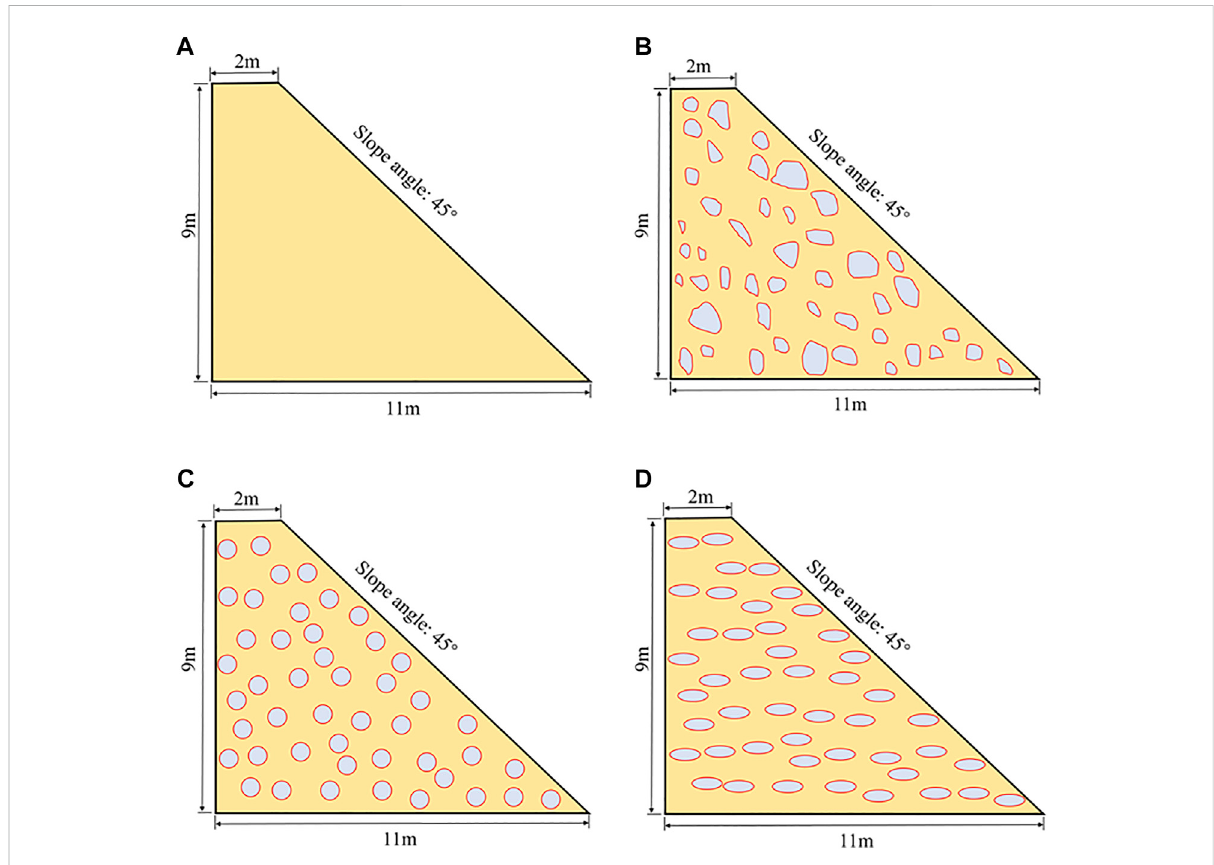
FIGURE 3 DigitalmodelofsoilslopeandSRMslope. (A) Solislope. (B) SRMslopewitharbitraryshapesofstones. (C) SRMslopewithroundstones. (D) SRM slope with oval stones.